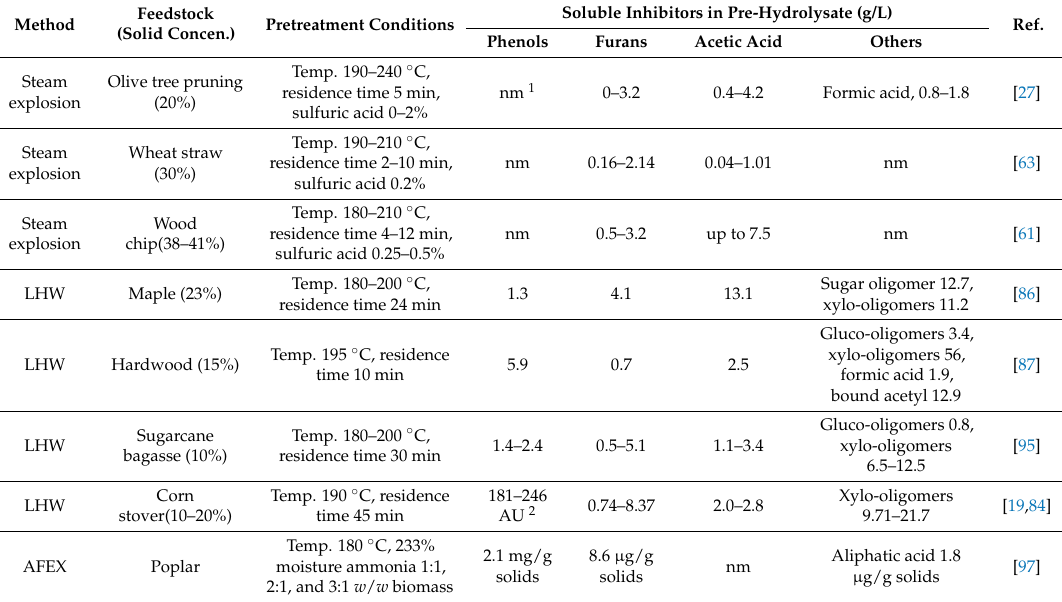
Table 3. An overview of aqueous soluble inhibitory compounds generated from physico-chemical